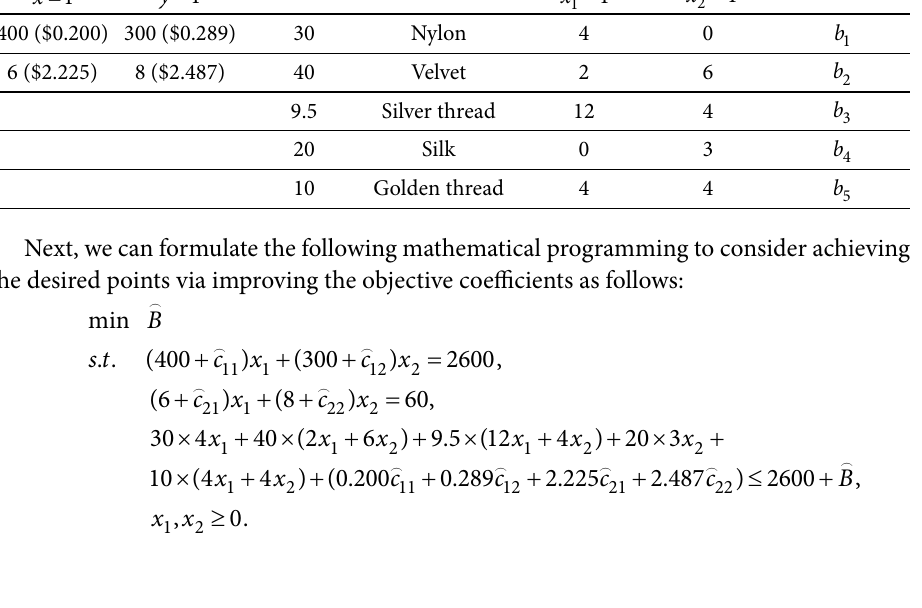
Technological coefficients No. of units 1 x = 2 1 x 1